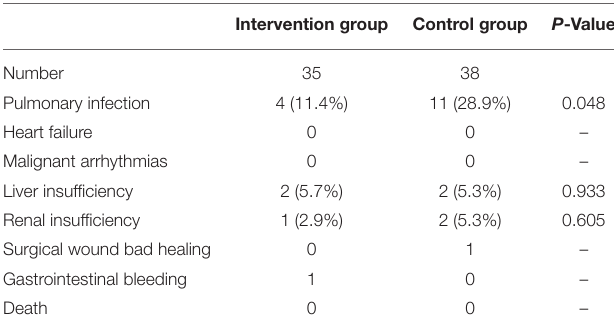
TABLE 3 | Comparison of the postoperative complications between the two groups [mean ± SD or